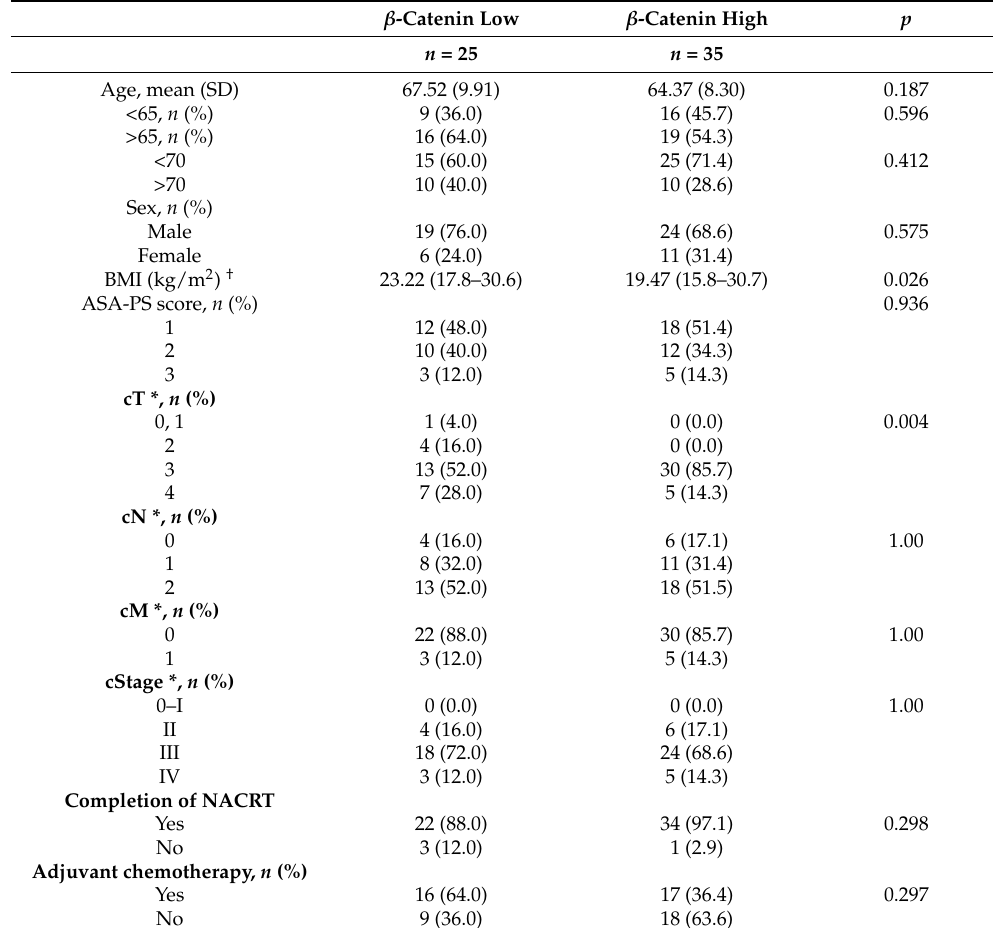
Table 1. Patient and tumor